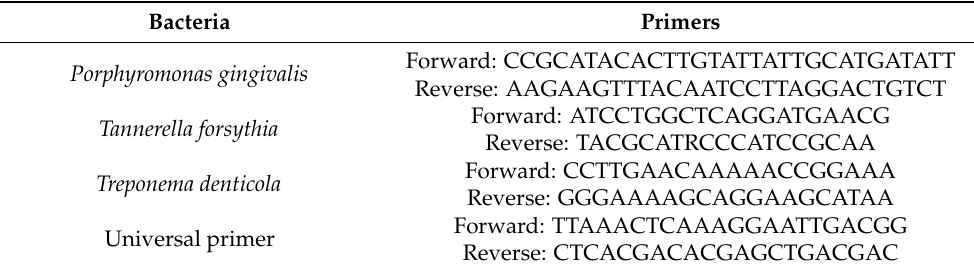
Table 1. Primers for periodontal